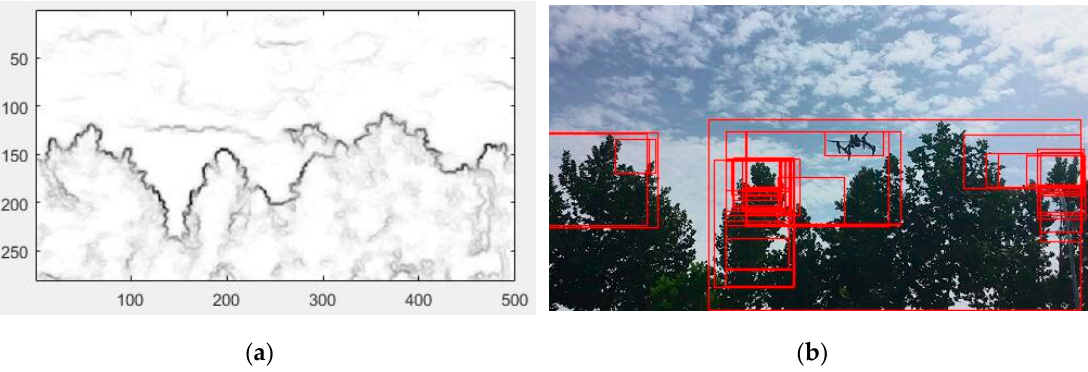
4 of 18 Table 1. Comparison of different region proposal methods. Method